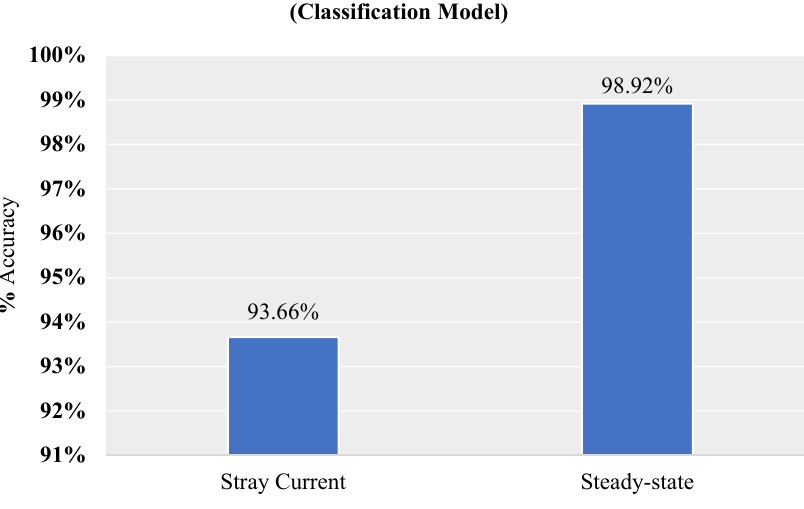
Figure 16. FDU CP pipe potential state prediction results.